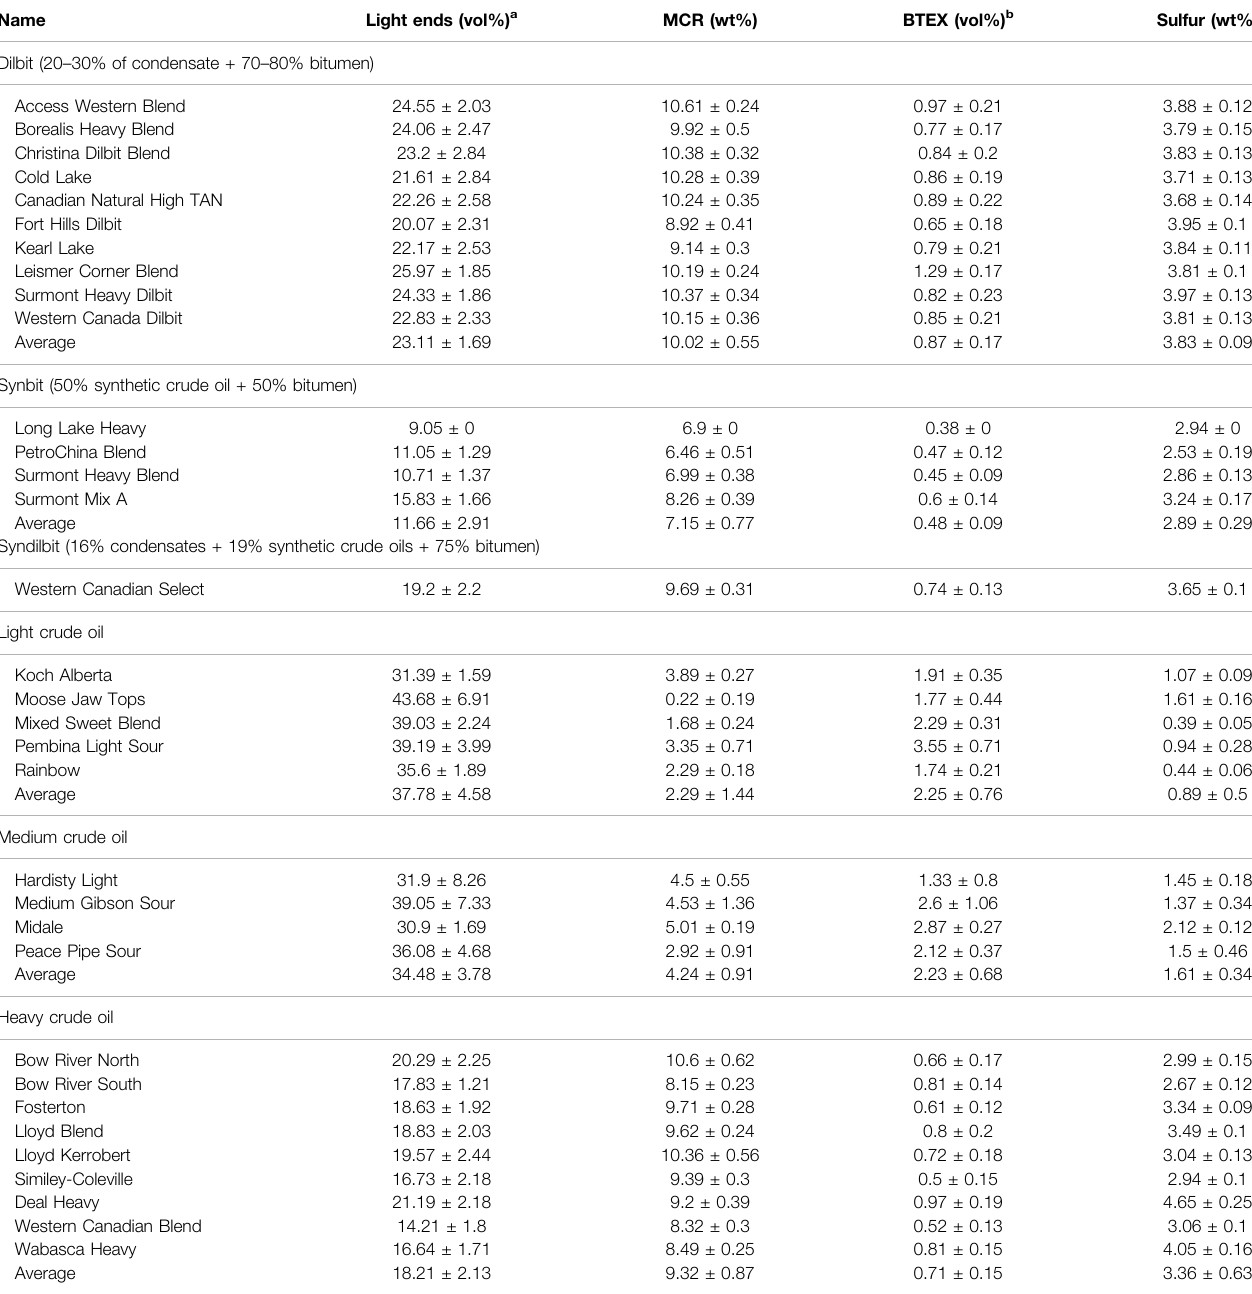
TABLE 3 | Chemical properties for diluted bitumen products made in Alberta (CrudeMonitor,